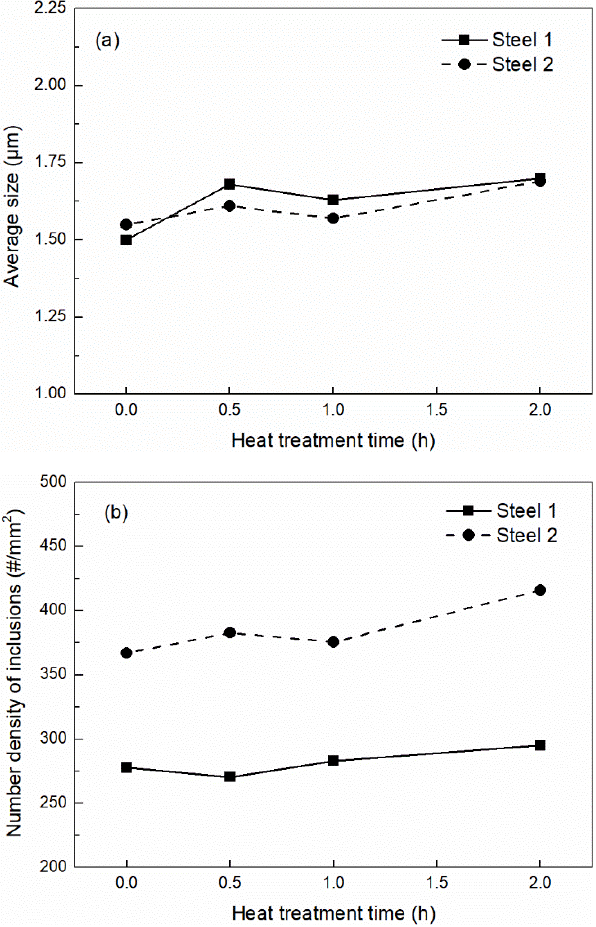
Figure 13. Change in average size ( a ) and number density ( b) of oxide inclusions during heating at 1473 K.